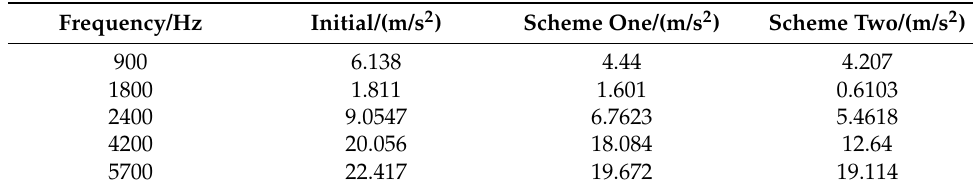
Table 5. Sound pressure level amplitude at major frequency